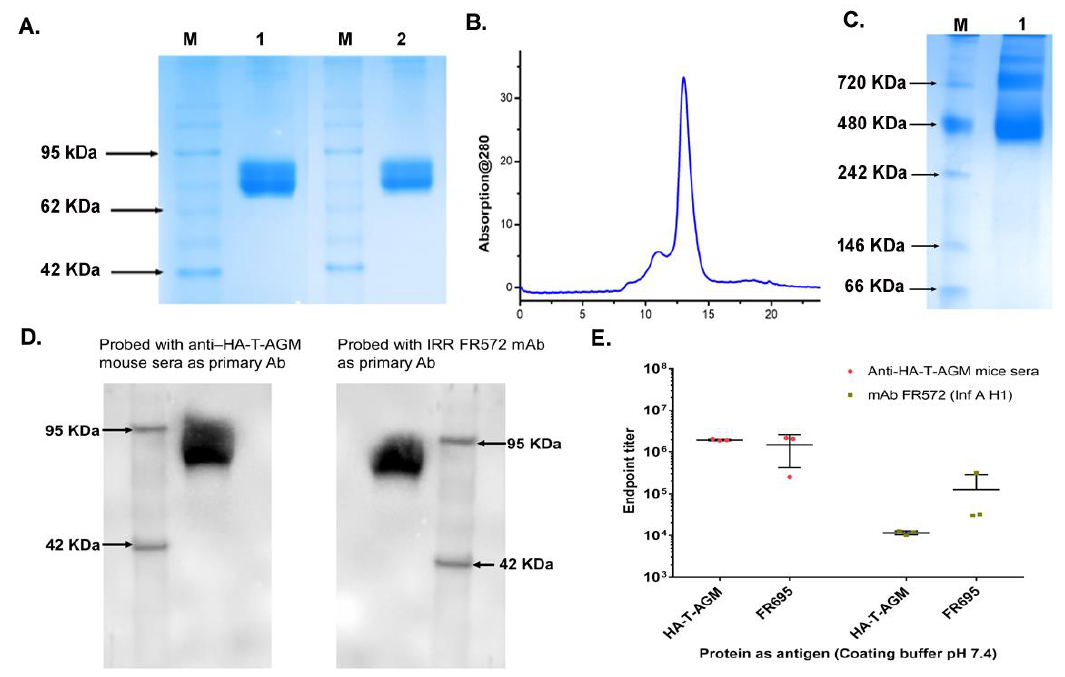
Figure 2. Antigenic characterization of HA-T-AGM protein. ( A ): SDS-PAGE results showing purified protein under reduced and non-reduced conditions; Lane 1 with reduced HA-T-AGM and Lane 2 with Non-reduced HA-T-AGM; M is a pre-stained marker ( B ): Elution profile after purification with Superdex 200 Increase 10/300 column showing a peak at elution volume ~11mL. ( C ): Native- PAGE showing oligomerization states of HA-T-AGM soluble protein ( D ): Immunoblotting of the recombinant HA-T-AGM protein onto PVDF membrane, probing with polyclonal mouse sera (1:500) as primary antibody and another blot with monoclonal antibody IRR FR572 (1:1000) followed by secondary IgG-HRP tagged anti-mouse antibody (1:2000) to develop the blot with help of chem- iluminescent substrates ( E ): ELISA results showing the endpoint titers of HA-T-AGM protein and commercial Influenza HA1 from Influenza A/California/07/2009 (H1N1) pdm09 [FR695]. The bind- ing efficiency of both proteins is tested against polyclonal mouse sera and mouse mAb FR572 raised against Influenza Type A (H1) pdm09.